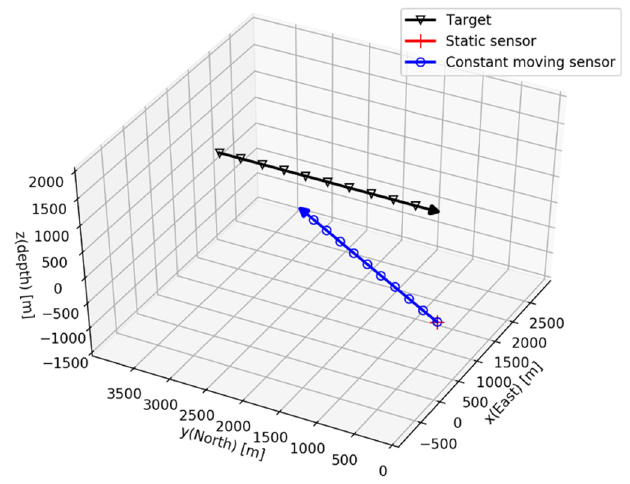
Figure 11. Simulation II: target and sensor trajectories.